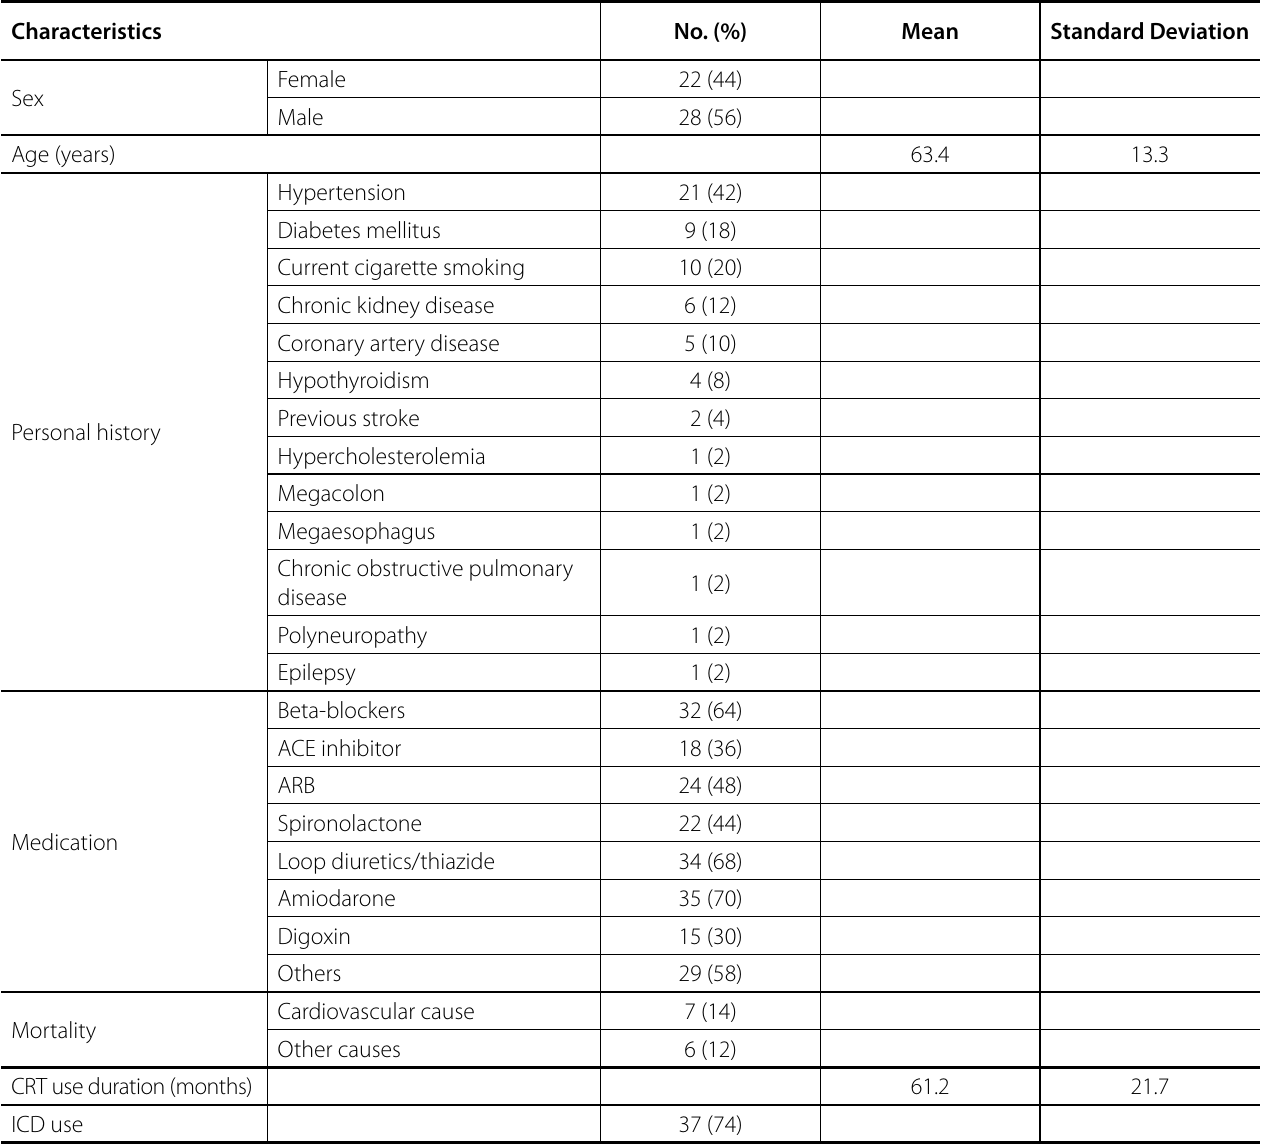
Table 1 . Patients’ characteristics.